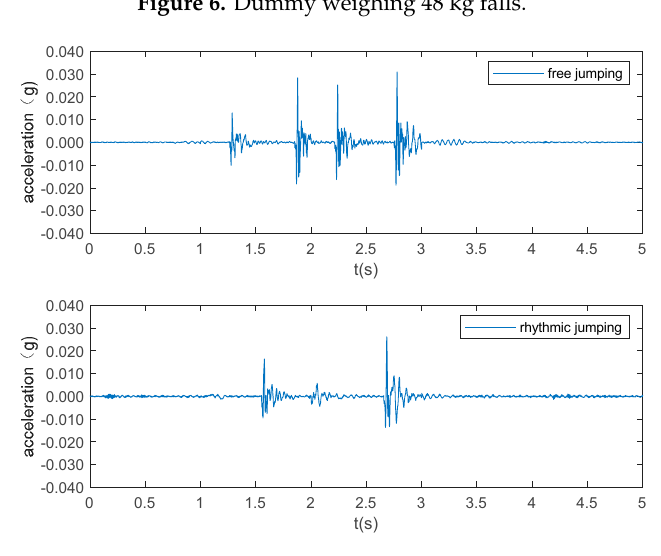
Figure 7. Volunteer weights 69 kg jumping.